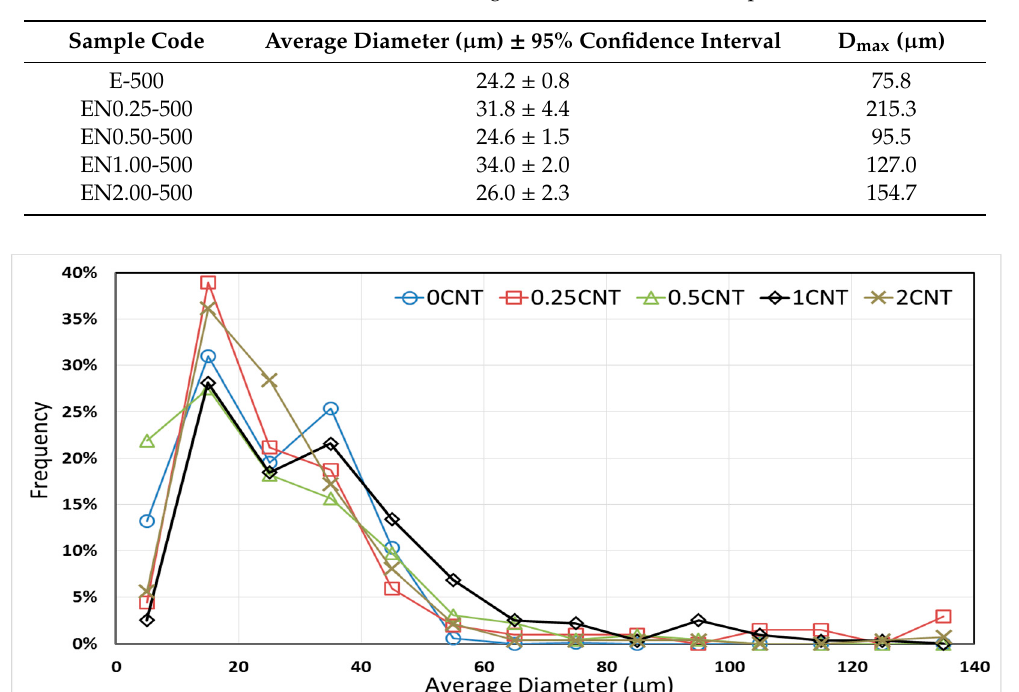
Table 4. Effect of mixing speed on average and maximum microcapsule diameters at 0.5 wt % CNT content.